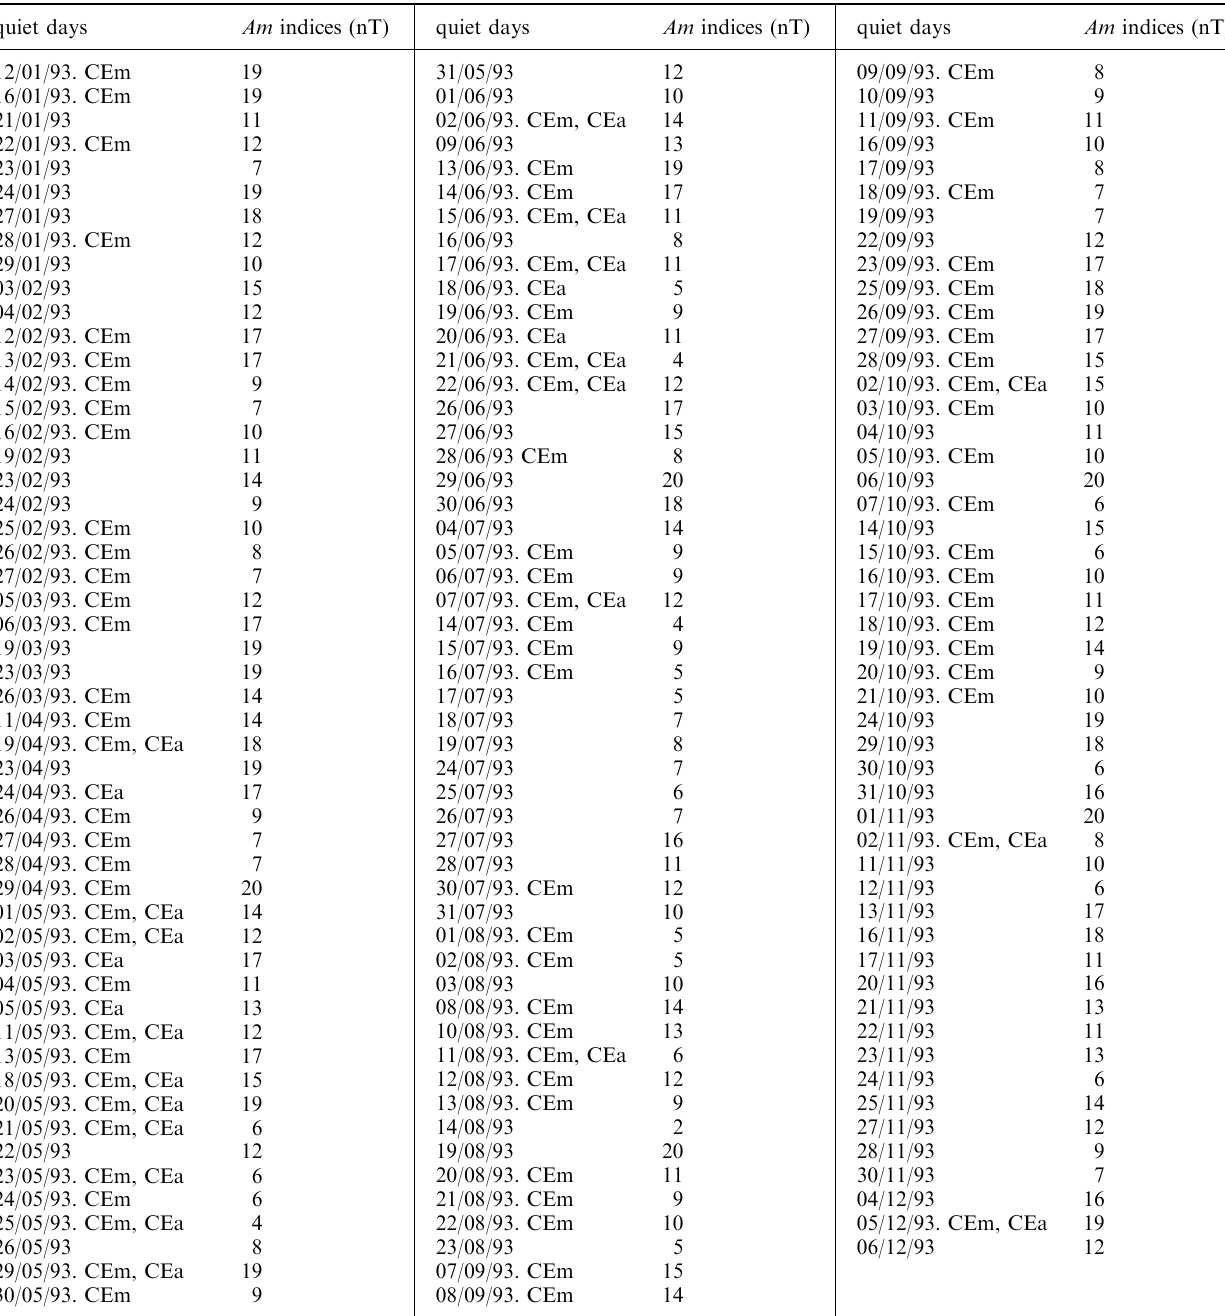
Table 2. Daily means of the magnetic activity indices ( Am ) for selected days 1993. Counter-electrojet days are indicated by CEm for morning counter electrojet and CEa for afternoon counter-electrojet quiet days Am indices (nT) 12/01/93.